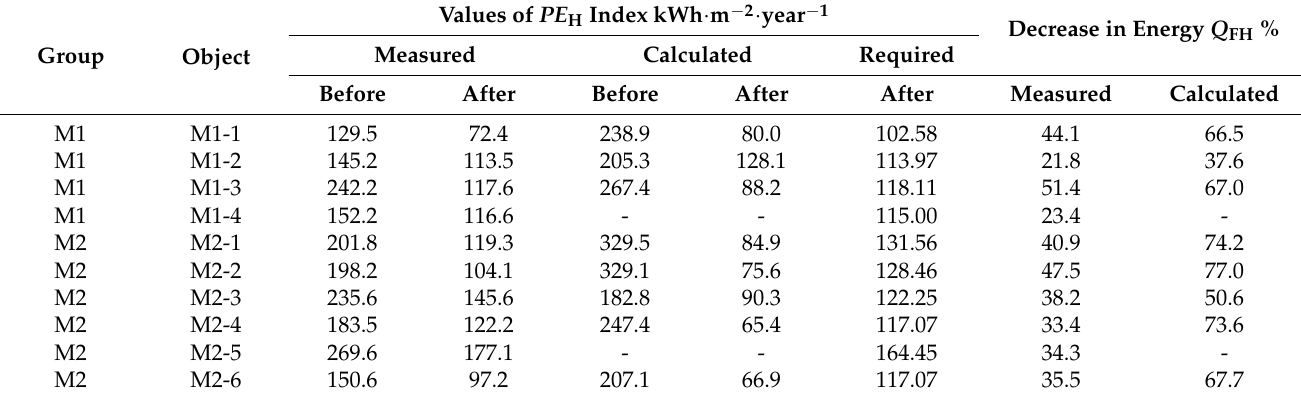
Table 11. Summary of calculation results, data from audits and required values of the PE H [kWh · m − 2 · year − 1 ] ratio and the decrease in energy Q FH [%].